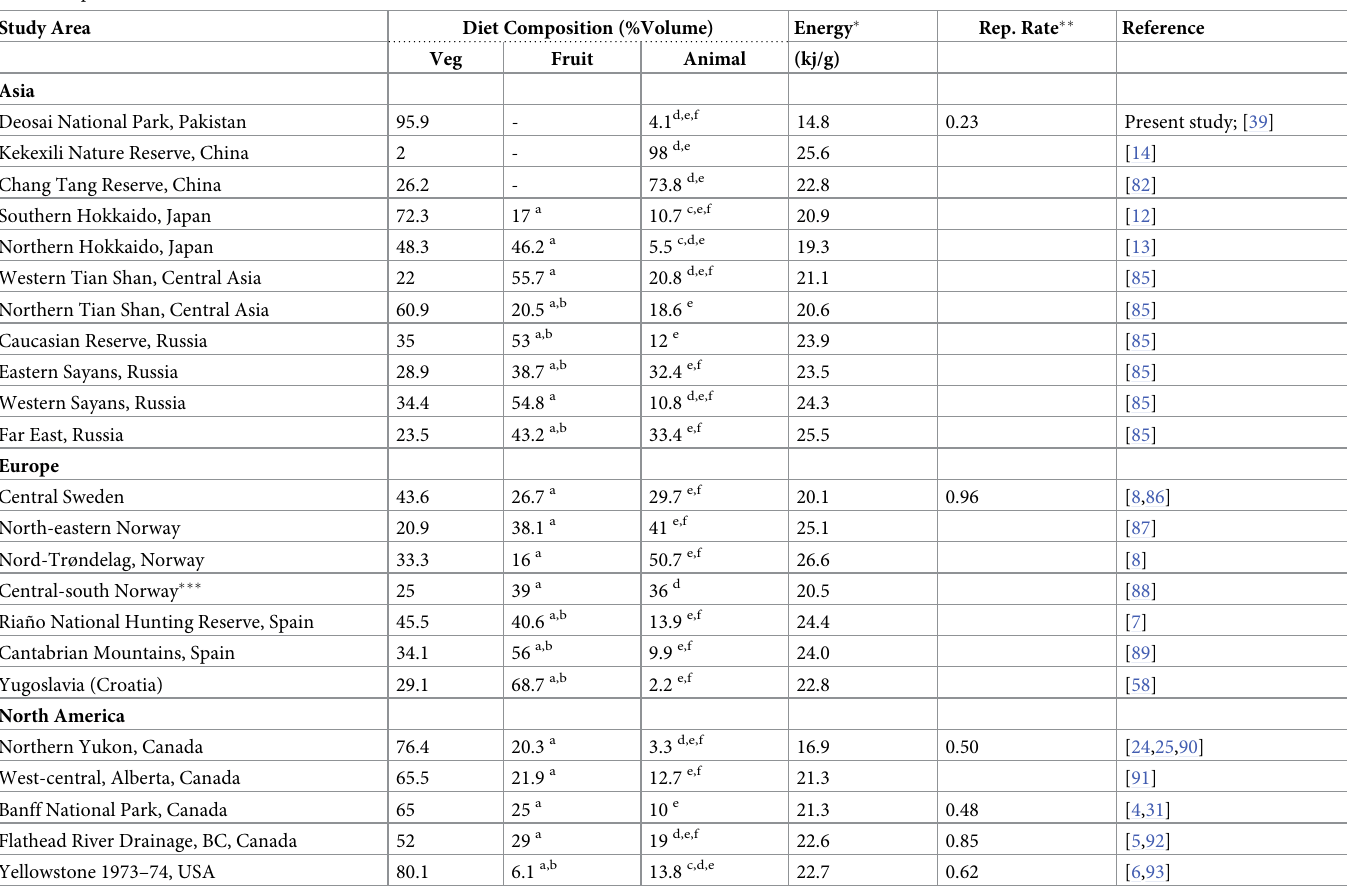
Table 4. Comparison of energy assimilation in the brown bear population of Deosai National Park with other brown bear populations from Asia, Europe and North America. Energy assimilated per gram of ingested food was calculated for these studies by applying correction factors [49] and energy estimates of food items [51] to relative percent